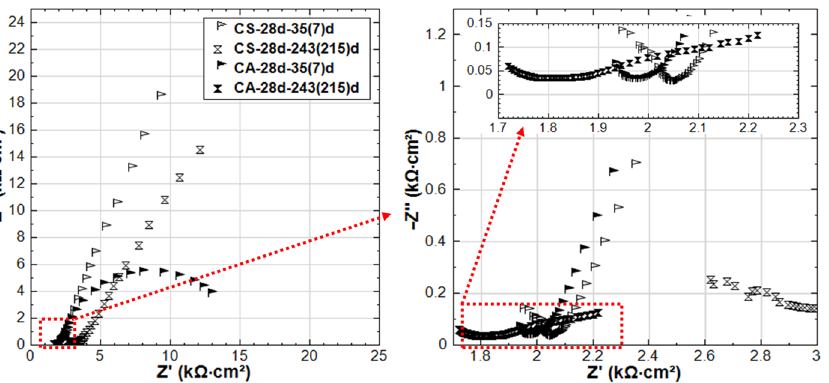
Figure 18. EIS responses overlay in Nyquist format of CS-28d and CA-28d (CS-28d: NaCl + Stray Current, CA-28d: NaCl + Anodic Polarization, 28d-cured specimens treated in 5% NaCl) at age of 35(7)d and 243(215)d.